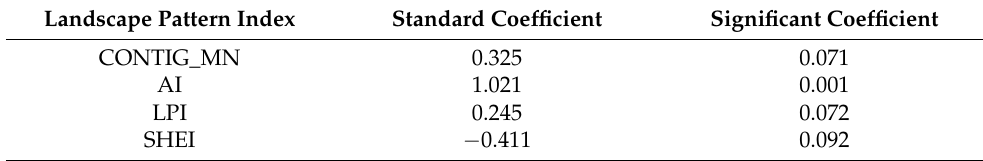
Table 4. Regression model parameters of the landscape pattern index and soil erosion. Landscape Pattern Index Standard Coefficient Significant Coefficient CONTIG_MN 0.325 0.071 AI 1.021 0.001 LPI 0.245 0.072 SHEI − 0.411